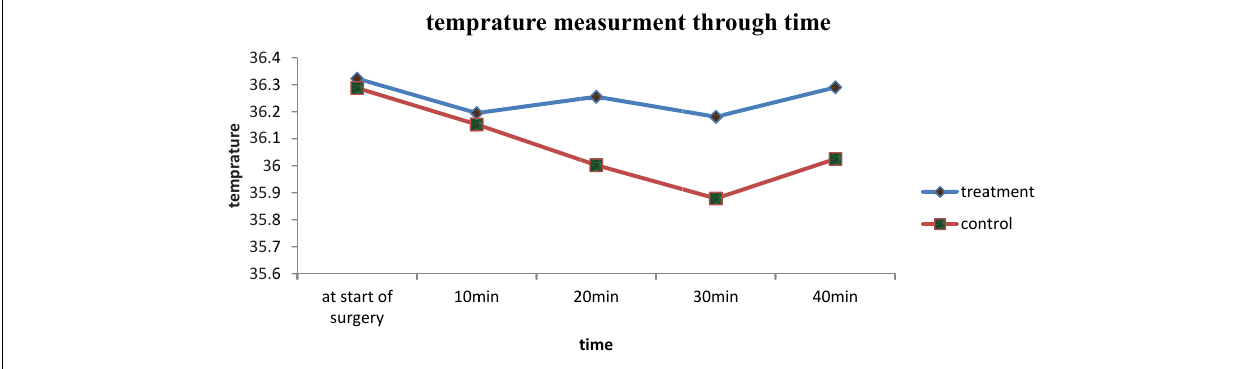
FIGURE 2 | Intraoperative axillary temperature measurement of treatment and control group in Dilla University Referral Hospital, 2021/22.